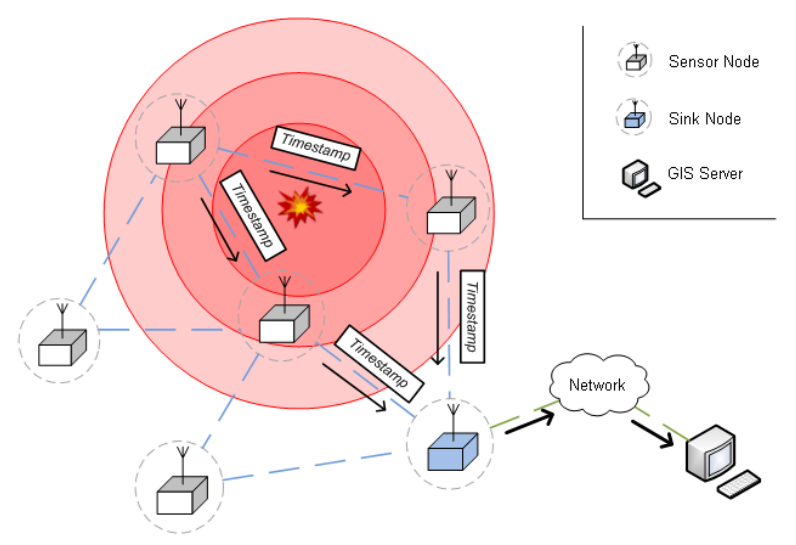
Figure 2. Gunshot location